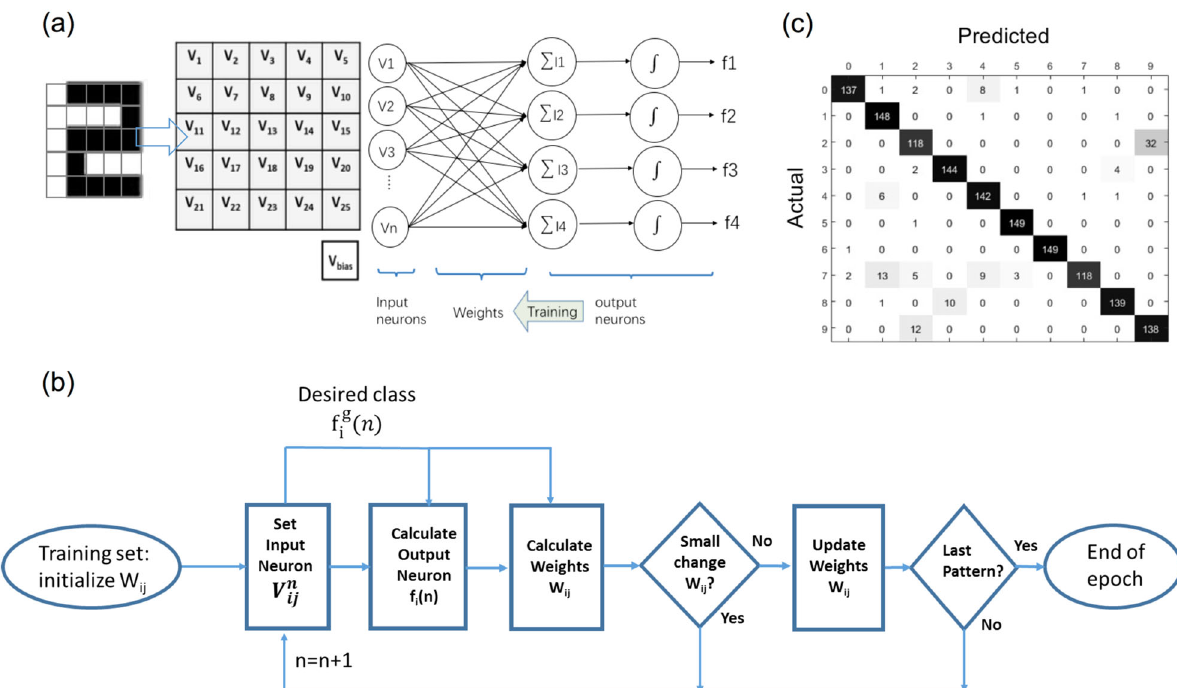
Fig. 6 Simulated neuromorphic network using FMT data. a Single-layer perceptron to classify 5*5 binary images. b Flow chart of the training algorithm. c Classi fi cation results, shown as a confusion